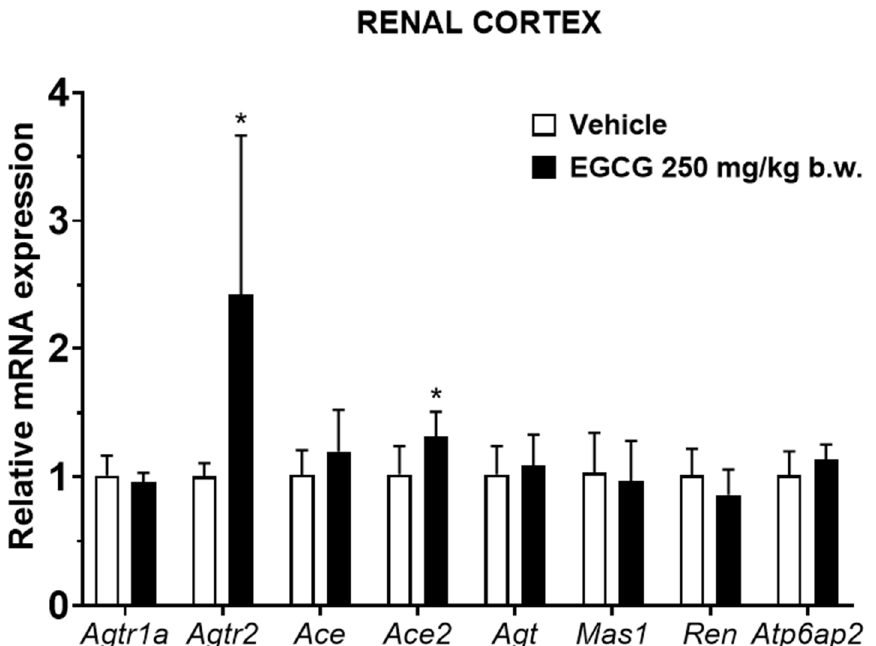
Figure 3. Relative mRNA expression of RAS related genes in renal cortex. Data were normalized to the Gadph gene expression and expressed as mean ± SD, n = 6. * p < 0.05 vs. vehicle, Student’s t -test .